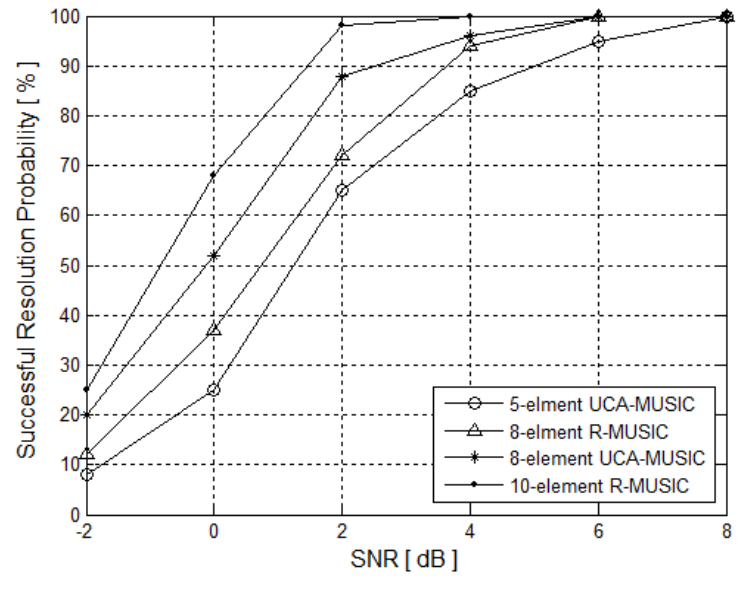
Figure 4. Successful resolution probability versus SNR.